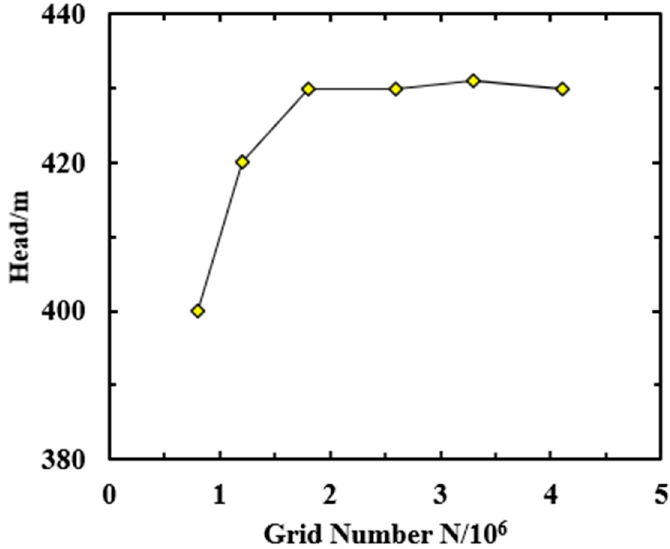
Figure 6. Computational domain grid schematic.